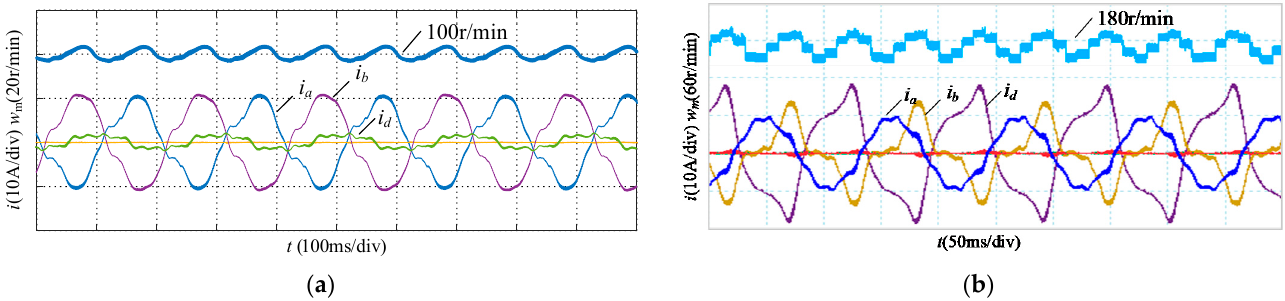
Figure 14. Experimental results of Phases c, e and f open fault under two kinds of control: ( a ) Dual current loops control. ( b ) Traditional current control.